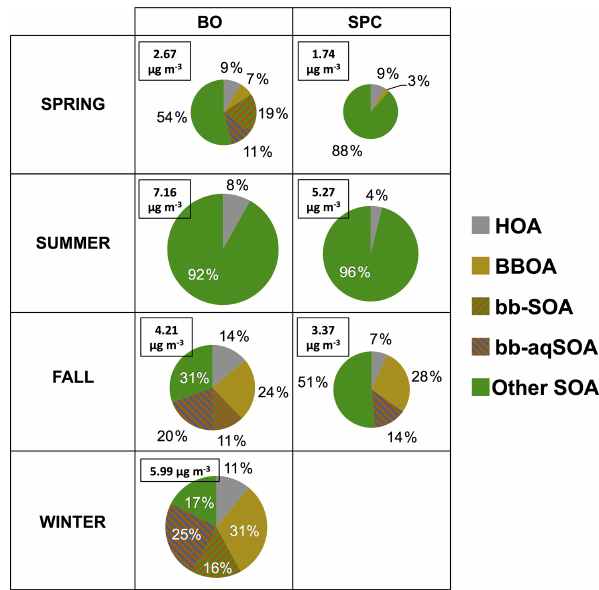
Figure 10. Seasonal relative contribution of the main OA sources at both the urban and rural sites with explicit separation also of the SOA (OOA) components. The pie-chart area is proportional to the total average concentration of OA (shown on the upper-left side of each box in terms of µgm − 3 ) and the individual portions are the averages between the different campaigns made at the site in one season. OOA factors influenced by biomass burning (charac- terized by a brown background color) are divided into the two cat- egories, “bb-SOA” and “bb-aqSOA”, representing the OOAx_BB and OOAx_BB-aq described in the text. “Other SOA” is the sum of the other OOA factors whose source has not been unequivocally